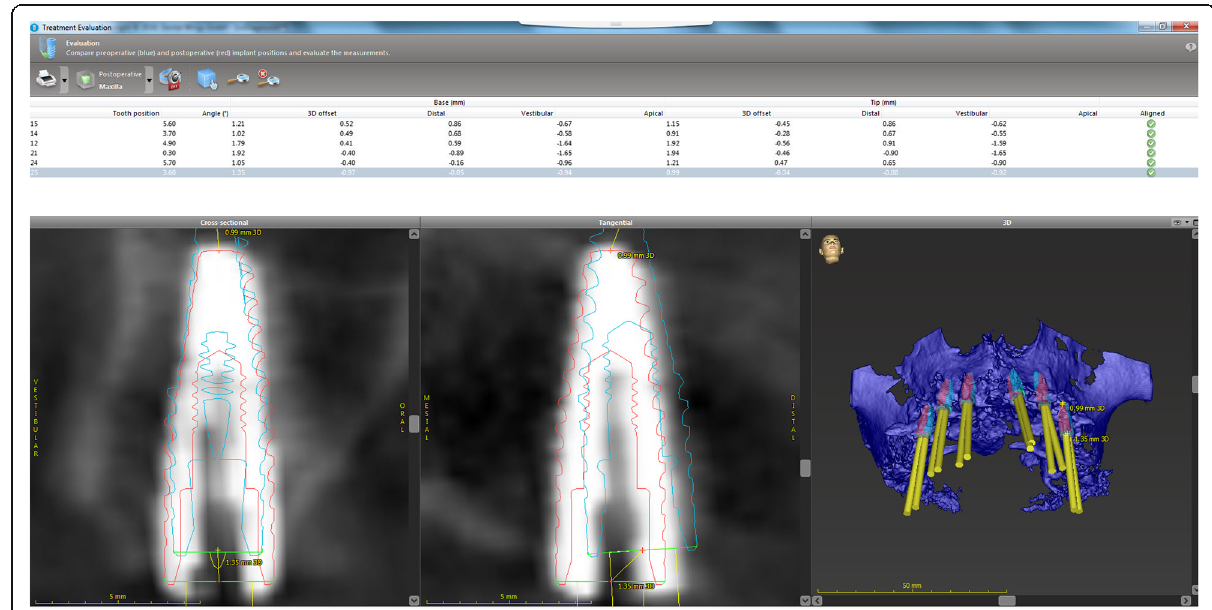
Fig. 1 Screen capture of the software-based 3D analysis of the implants placed in the Maxilla. Lower figures are the comparison of the planned position (blue contour line) and the actual insertion (red contour line) of